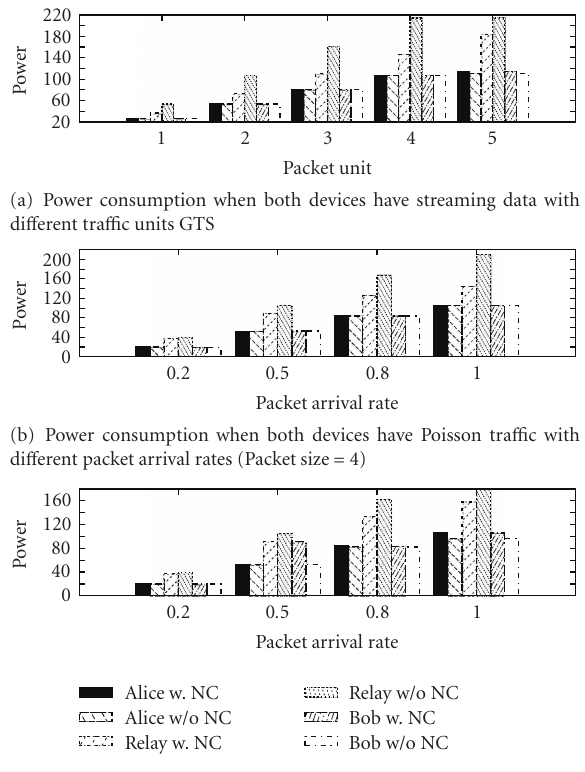
Figure 4: Power consumption